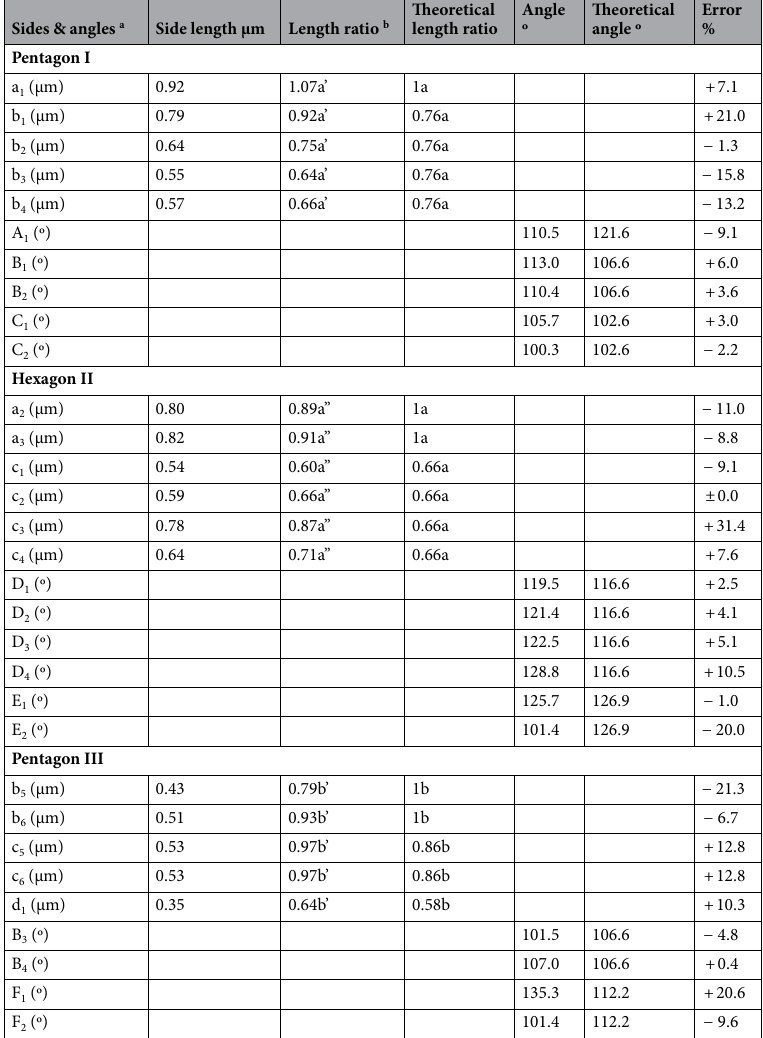
Table 1. Structure comparison of polyhedrons observed in 3D SEM with theoretical structure in the Weaire- Phelan structure. a: Coordinate points are available in supporting information, b: a 1 + b 1 + b 2 + b 3 + b 4 =